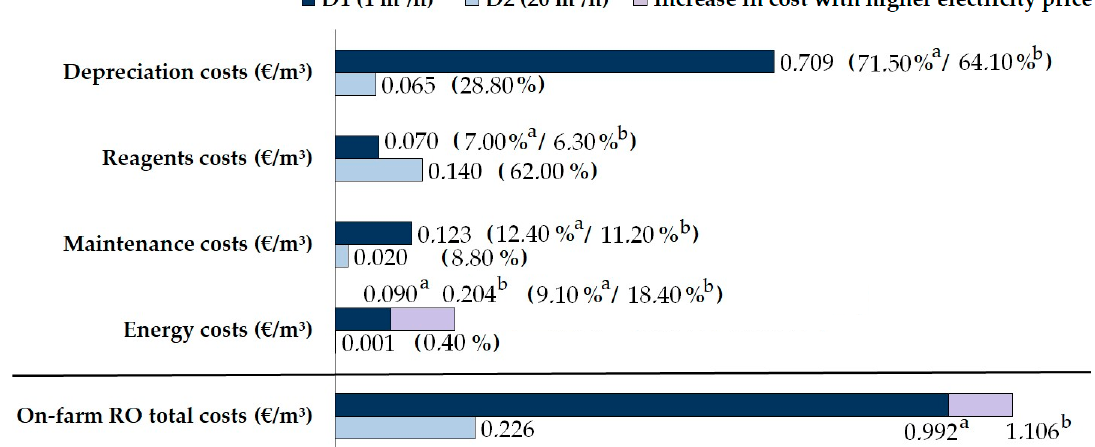
Figure 8. Depreciation and specific operating costs for the D1 (with regeneration every 50 h) and D2 boron removal systems. The superscripts a and b indicate the variation in each cost considering lower (EUR 0.134/kW·h) and higher electricity prices (EUR 0.30/kW·h), respectively.